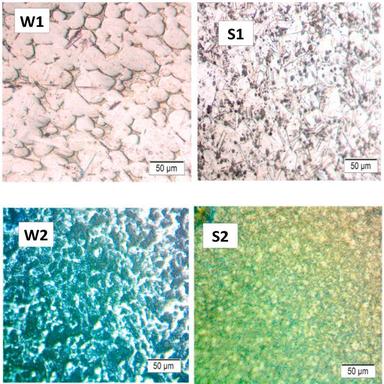
Optical micrographs for the W1, W2, S1 and S2 investigated alloys, Mag 20X